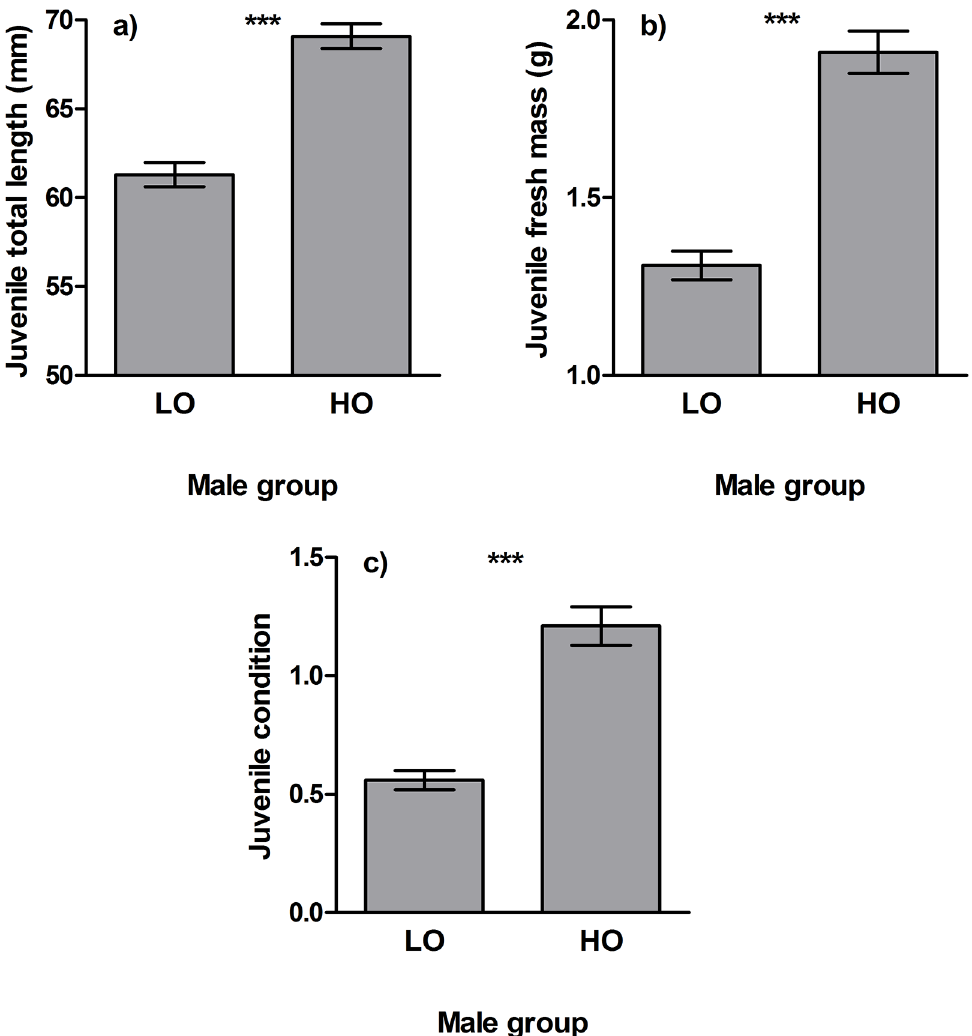
Fig 3. Juvenile total length (a), fresh mass (b) and condition (c) differences ( ± S.E.) between less-ornamented (LO) and highly-ornamented (HO) males. Asterisks indicate statistically significant differences between male groups ( *** : P <